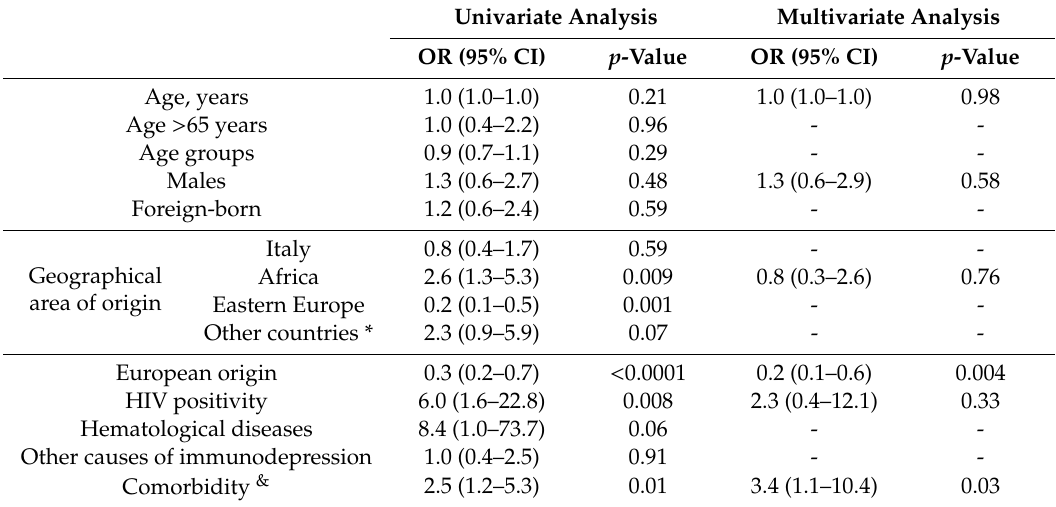
Table 3. Logistic regression analysis to assess the relationship between demographic and clinical characteristics and extrapulmonary